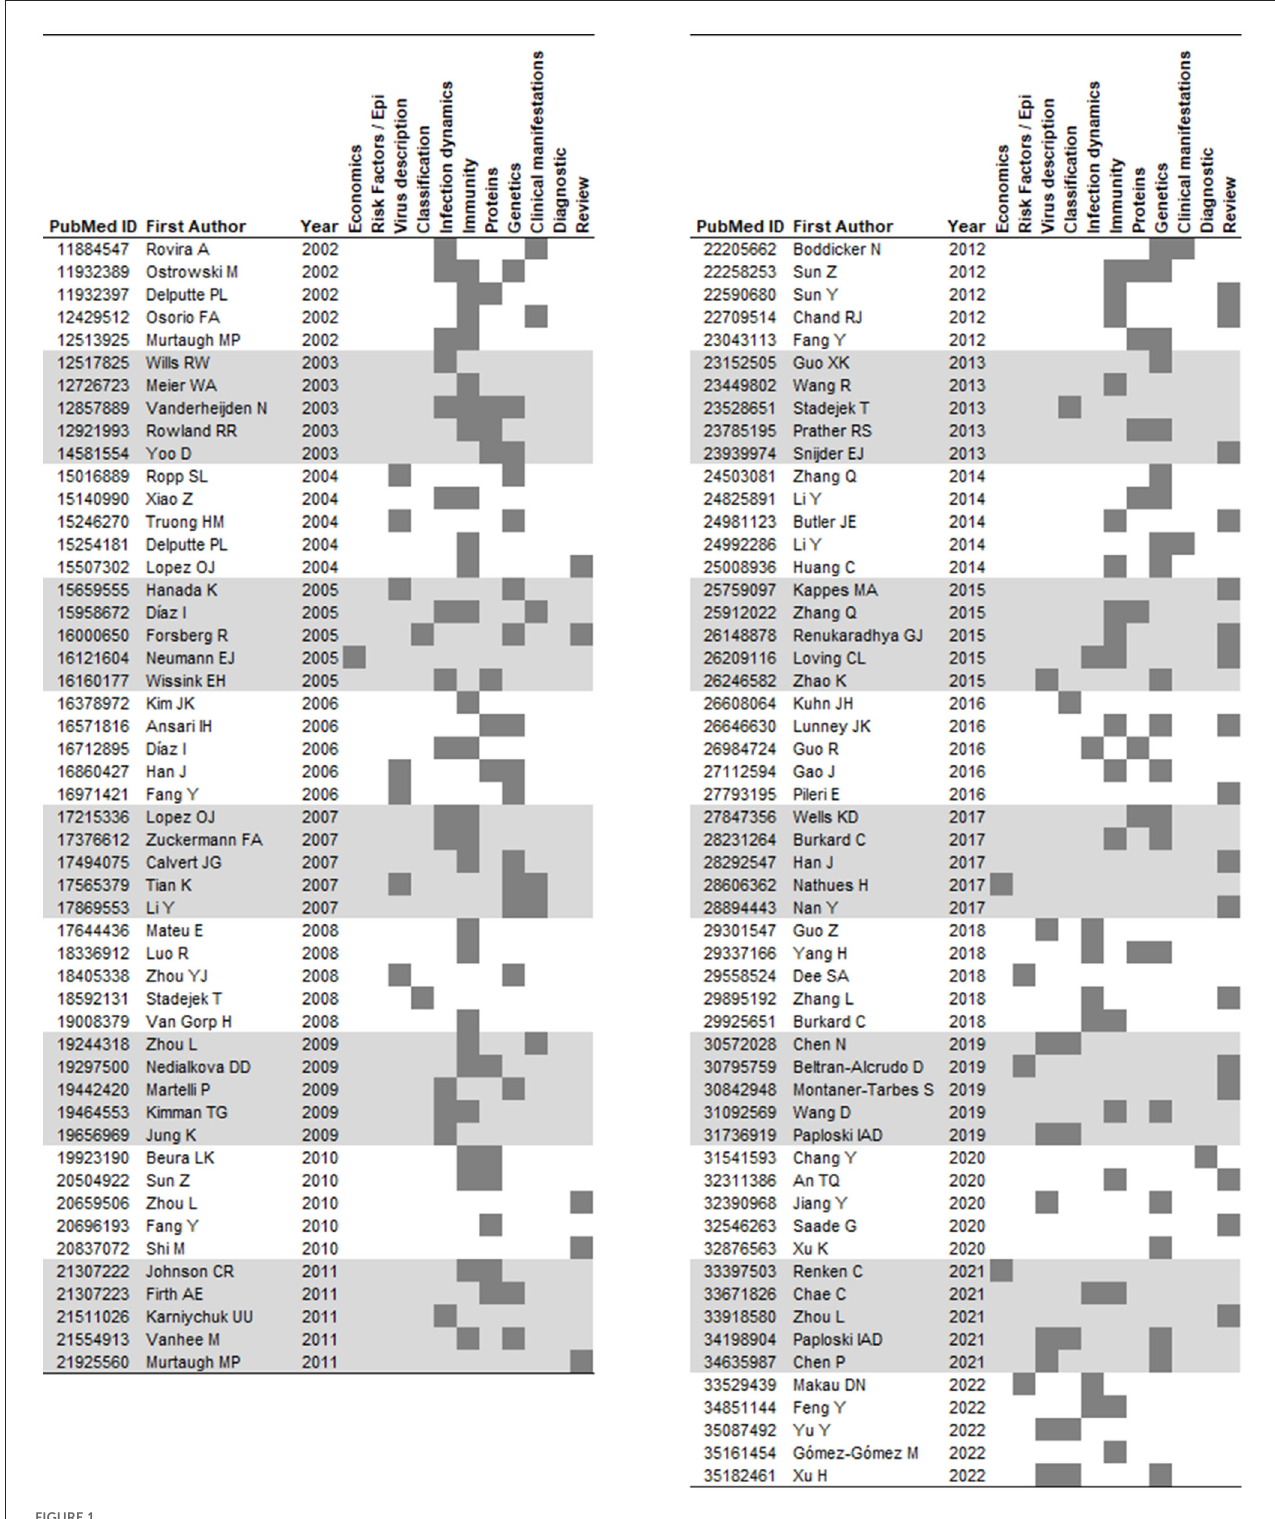
the reviewed papers. Interestingly, not a large fraction of the top-cited papers were related to